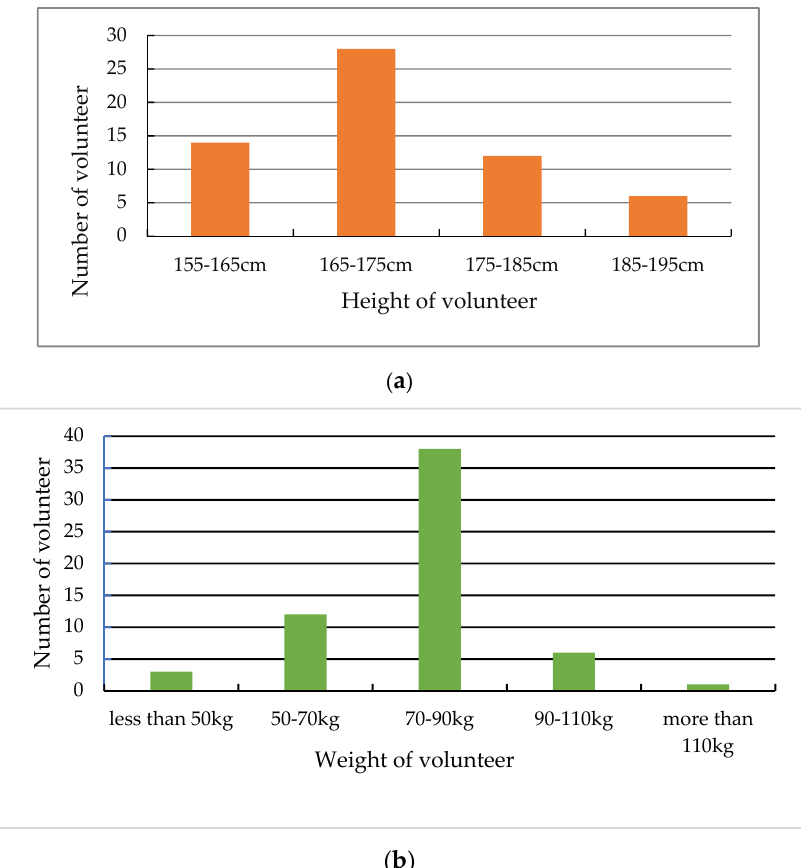
Figure 19. The basic information of the volunteer. ( a ) The distribution of the volunteers under the height factor; ( b ) the distribution of the volunteers under the weight factor.